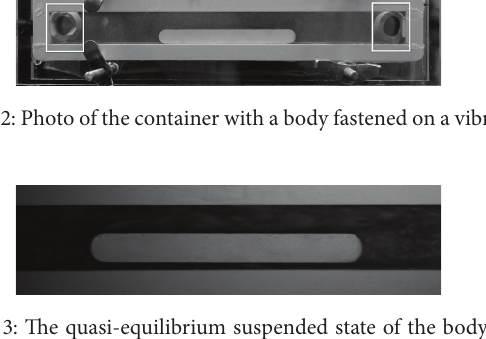
container ends takes place in occasional way. With decrease of vibrations intensity, the body returns to the bottom.